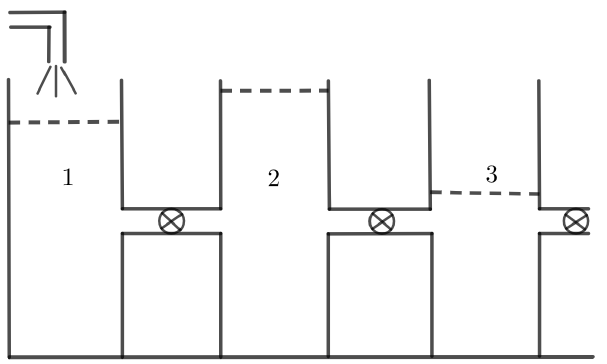
Figure 4. Schematic representation of the extended three-tank system.